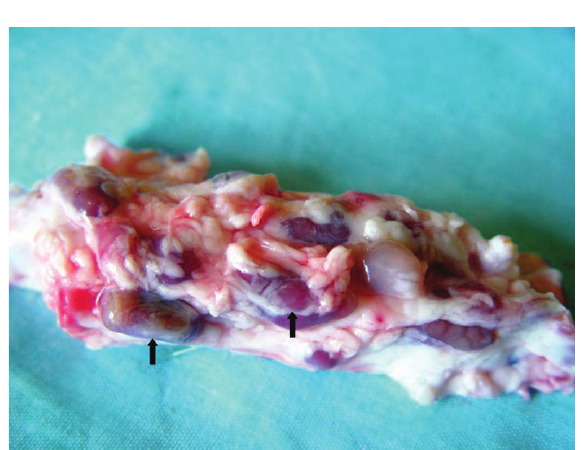
Fig. 3 - Linfoadenomegalia periaórtica limitada à região do stent. As setas indicam os linfonodos aumentados.